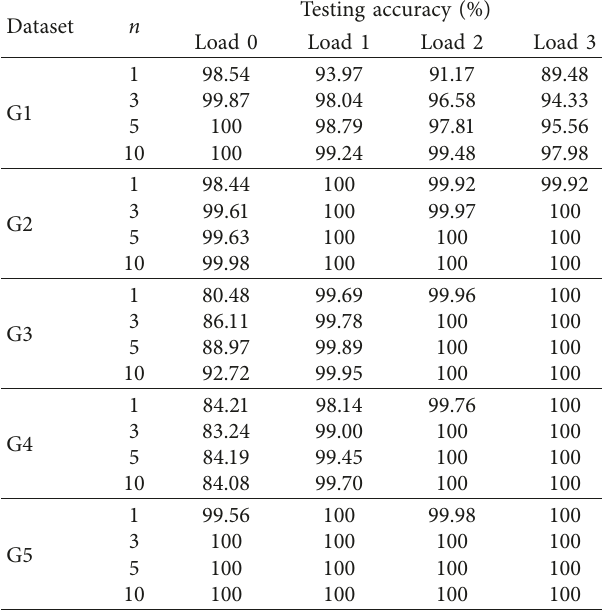
Table 8: The classification accuracy for multiclass fault severity detection.